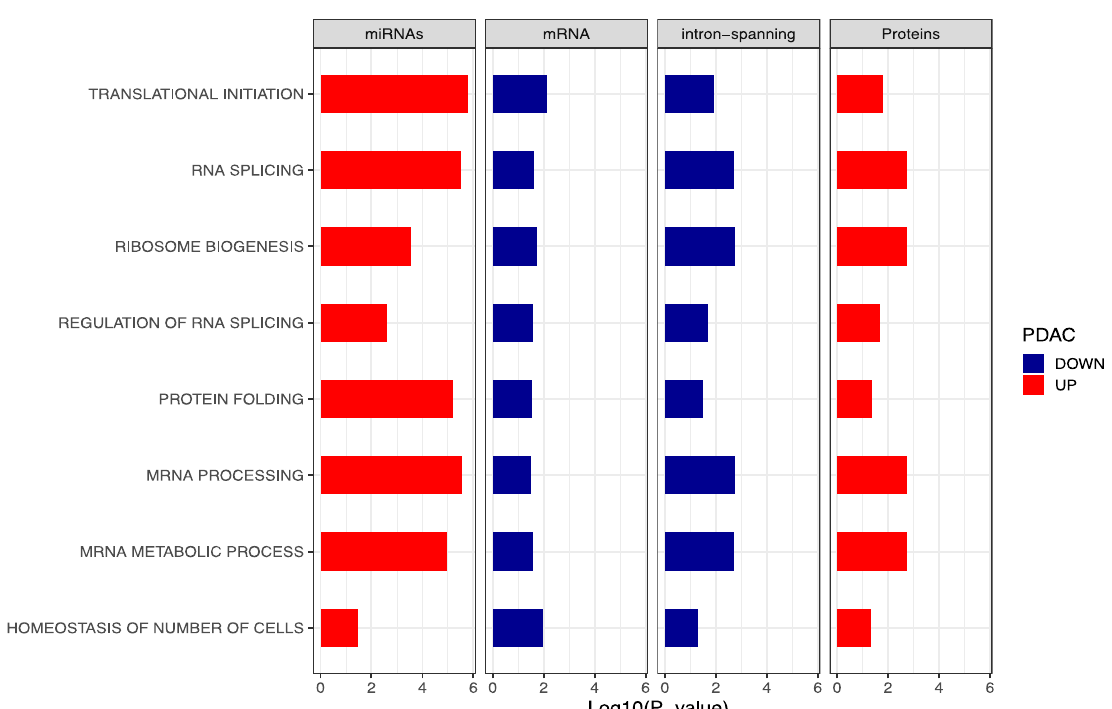
Figure 5. Gene ontology mining. Overlapped of significant GO terms for miRNAs, mRNAs, intron-spanning reads and proteins. Red bars describe biological terms enriched in PDAC platelets while blue bars identify biological terms down-regulated in PDAC platelets.